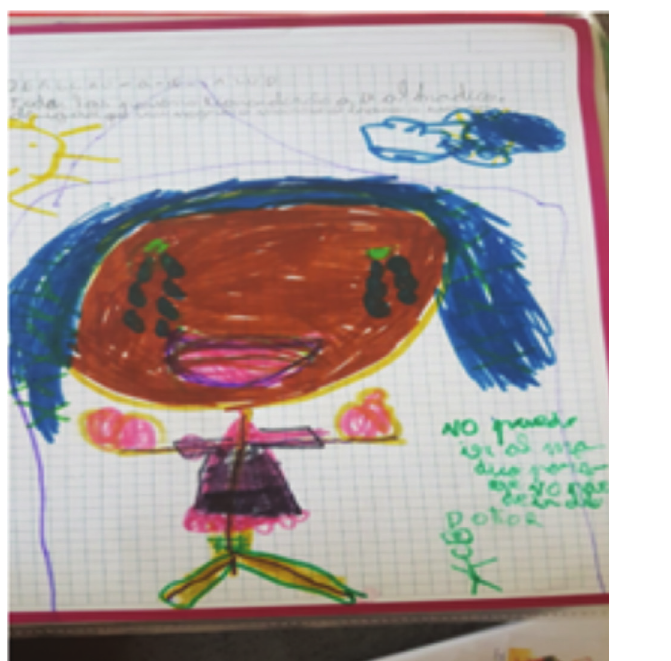
Figure 3: Drawing by a primary school student and an infant school student explaining what the right to health means for them (Photograph: Author,